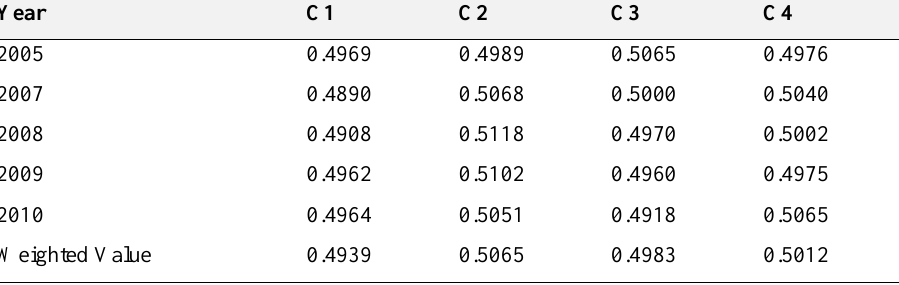
Table 7 – Weighted Value obtained through the Principal Component